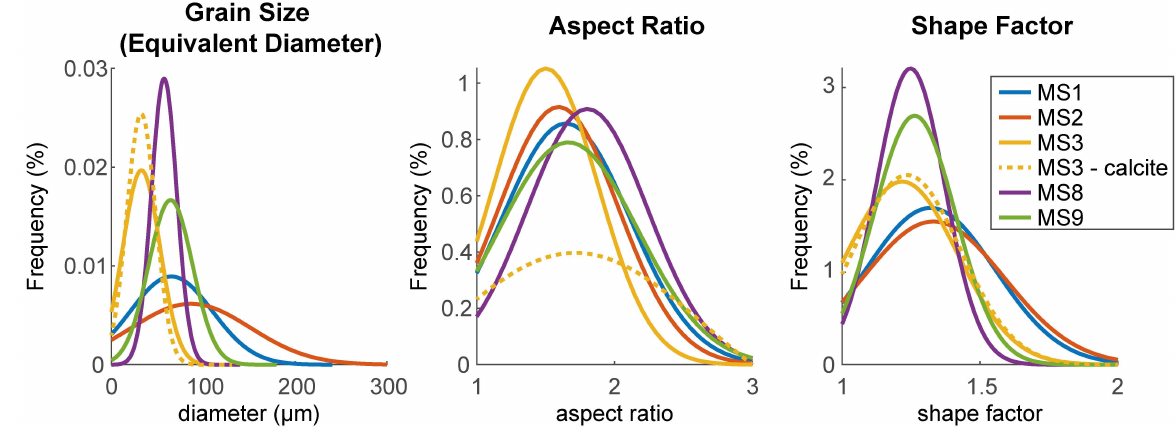
Figure 7. Compilation of the grain sizes, aspect ratios, and shape factors of the samples using kernel density estimations.